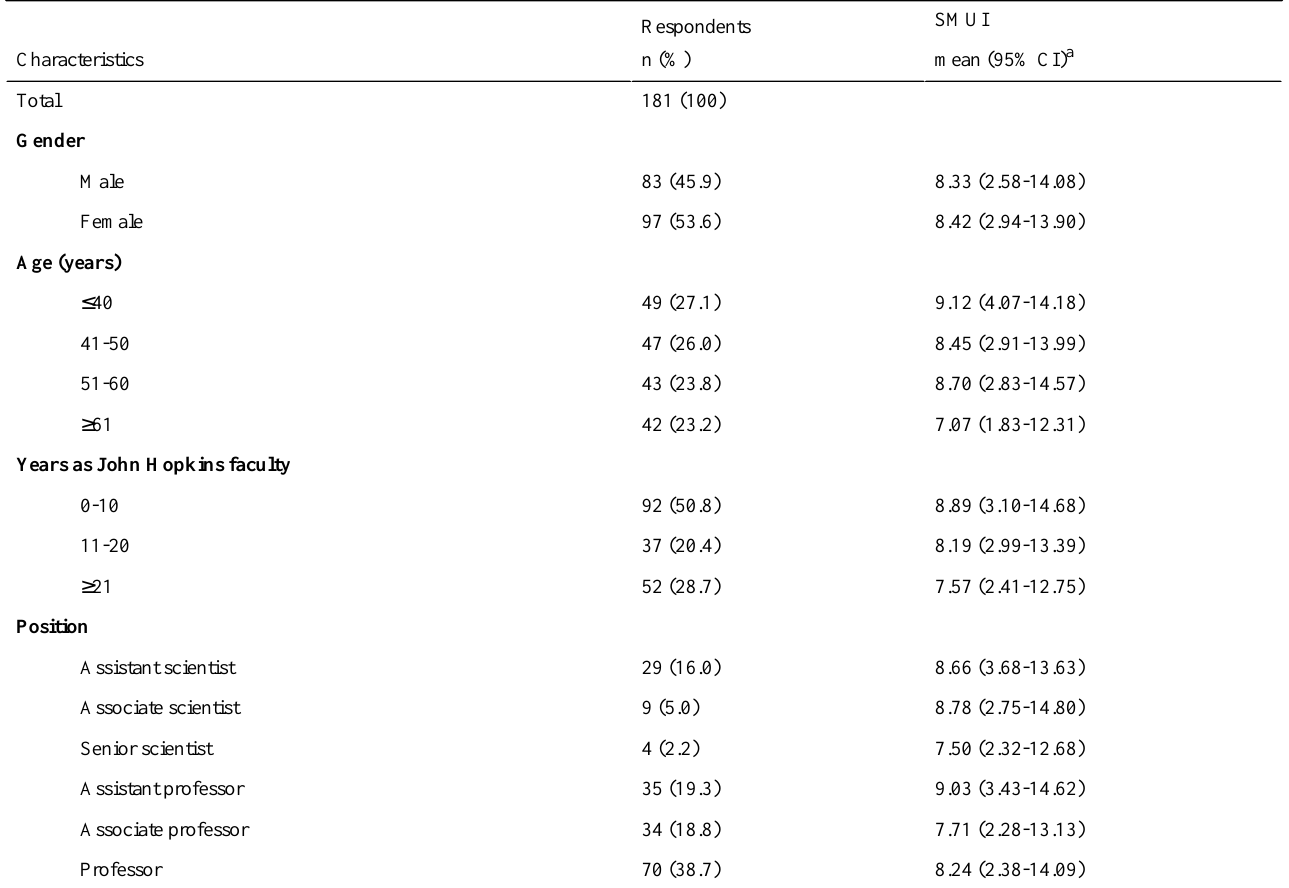
Table 1. Social Media Usage Index (SMUI) score by respondent